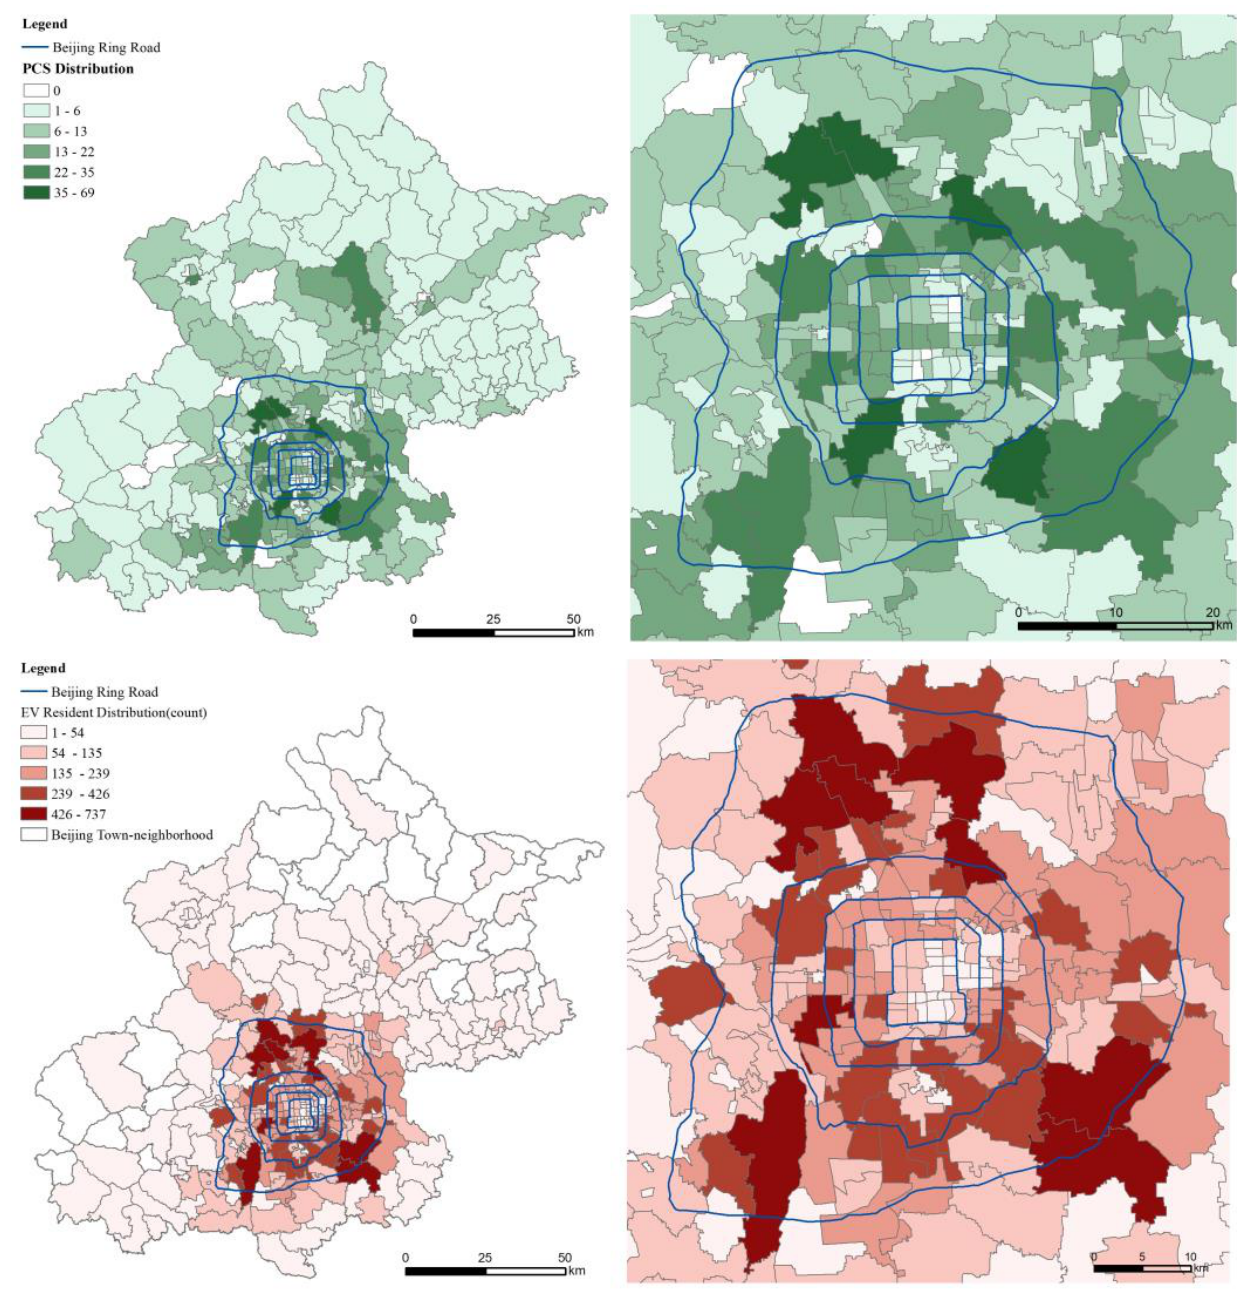
Figure 4. Distribution of public charging stations and EV users’ residential areas at the town-neighborhood level. The majority of EV users live between the fourth and sixth ring roads, especially in the northern and southern regions. In contrast, the deployment of public charging stations shows partly consistency with this pattern, regarding it indicates a certain correlation with large employment areas.